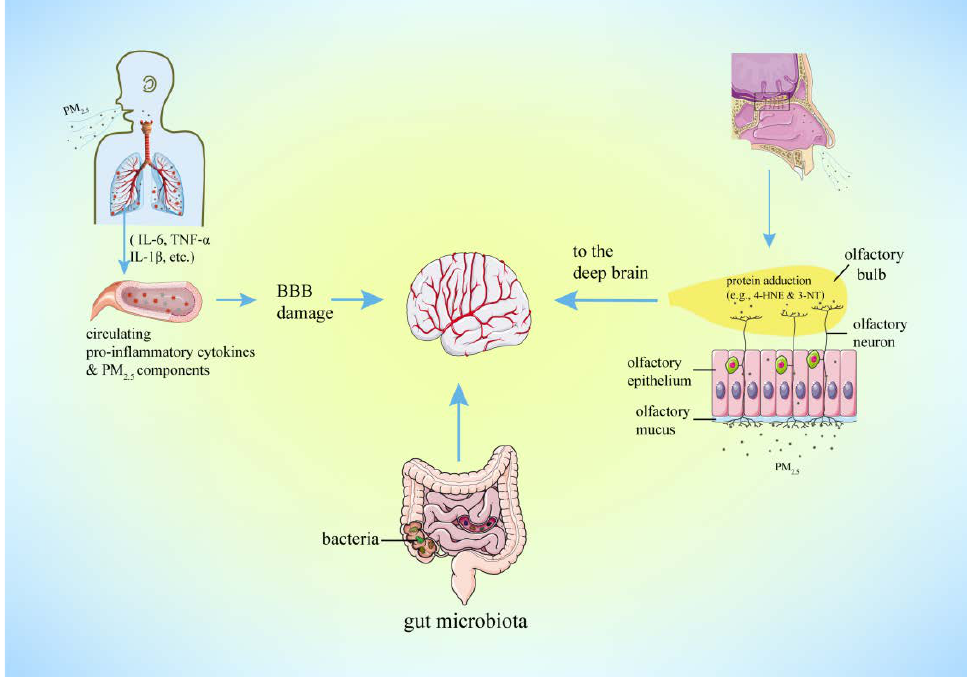
Figure 2. The routes that PM 2.5 enters the brain. The lung–brain axis and olfactory pathway are two recognized predominant routes that PM 2.5 takes into the brain. Once inhaled, PM 2.5 can quickly diffuse throughout the alveoli and lead to lung inflammation. These circulating cytokines (IL-6, TNF- α , IL-1 β , etc.), in combination with soluble components of PM 2.5 , cross the BBB directly or via a disruption to the permeability of the BBB, and then induce microglia activation and neurotoxicity. Meanwhile, with a consequence of lipid peroxidation (4-HNE and 3-NT protein adduction), PM 2.5 could also gain access to the olfactory bulb through the olfactory epithelium and then move into the deep regions of the brain. Moreover, the gut–brain axis is potentially another route through which PM 2.5 exerts its neurotoxicity, which is probably associated with the dysbiosis of gut microbiota.